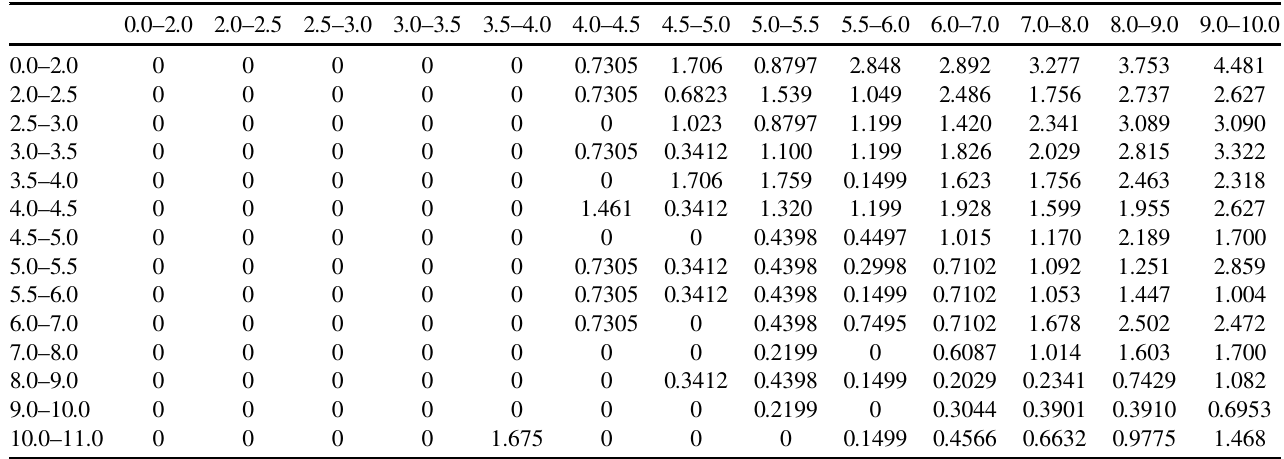
TABLE XX. (cid:4) þ background from (cid:3) (cid:5) CC events (all values (cid:2) 10 (cid:1) 4